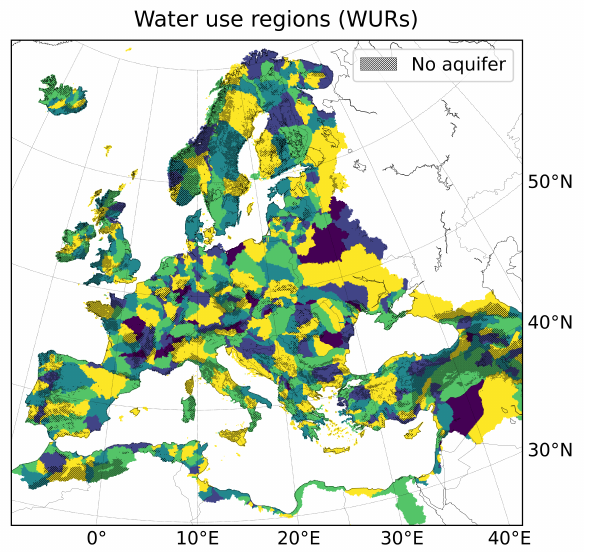
Figure 1. Water use regions (WURs) over the Euro-Mediterranean model domain, where areas without exploitable aquifers are barred. Adjacent WURs are mapped with distinct